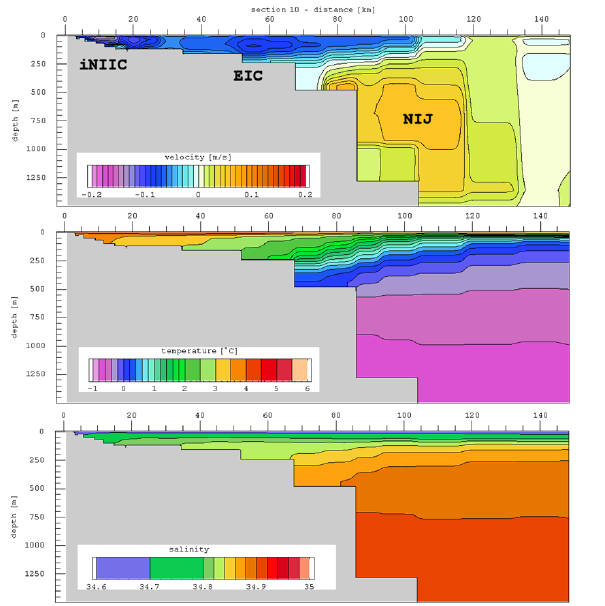
Fig. 11. Simulated 1992–2006 mean of flow (positive (red) values denote north-westward flow), temperature and salinity across sec- tion 10. See Fig. 6 for section location.